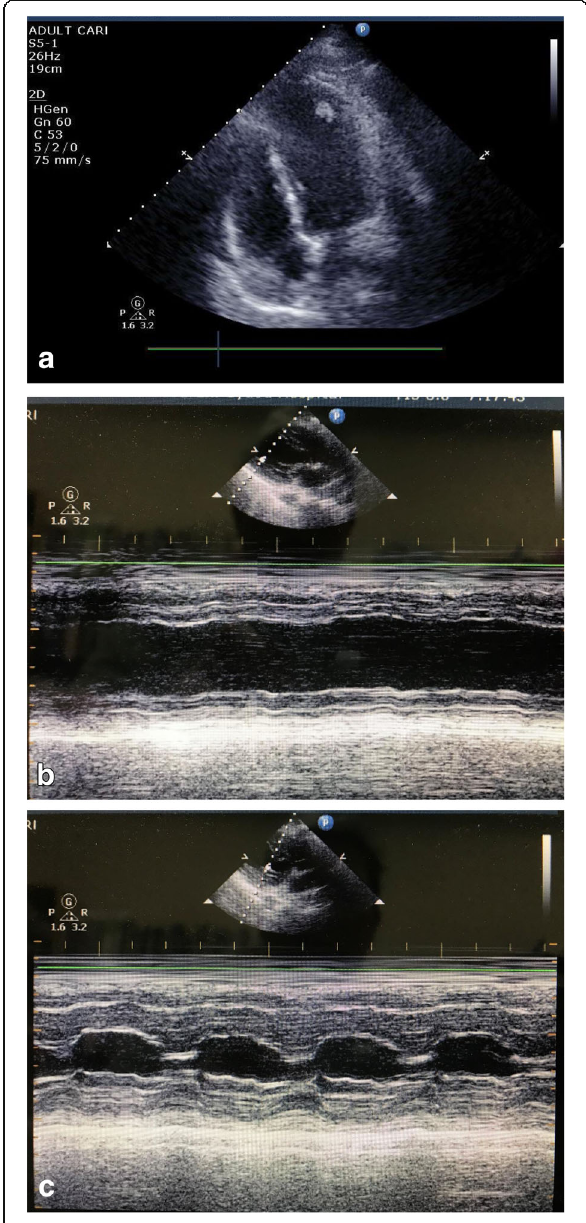
Fig. 3 Results from the transthoracic echocardiography (TTE) performed at the ICU. A thrombus can be seen at the apex of the left ventricle. a Left ventricular thrombus. b Severe hypokinesis in apical segments. c Preserved contractile in basal